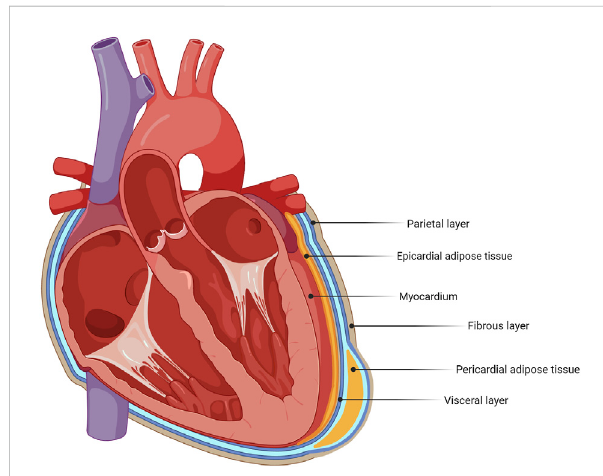
Schematic identifying adipose tissue deposits around the heart. Thehearthasdifferentadiposetissuedeposits,withepicardialadipose tissue (EAT) and pericardial adipose tissue (PAT) as its main